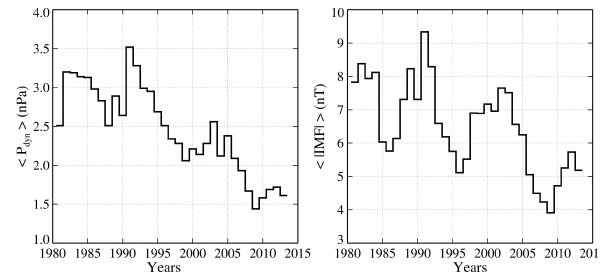
Figure 3. Variation of the annual averages of the solar wind ram pressure (left) and of the IMF magnitude (right) for the period from 1981 through 2013. A long-term decreasing trend for both quanti- ties is clearly